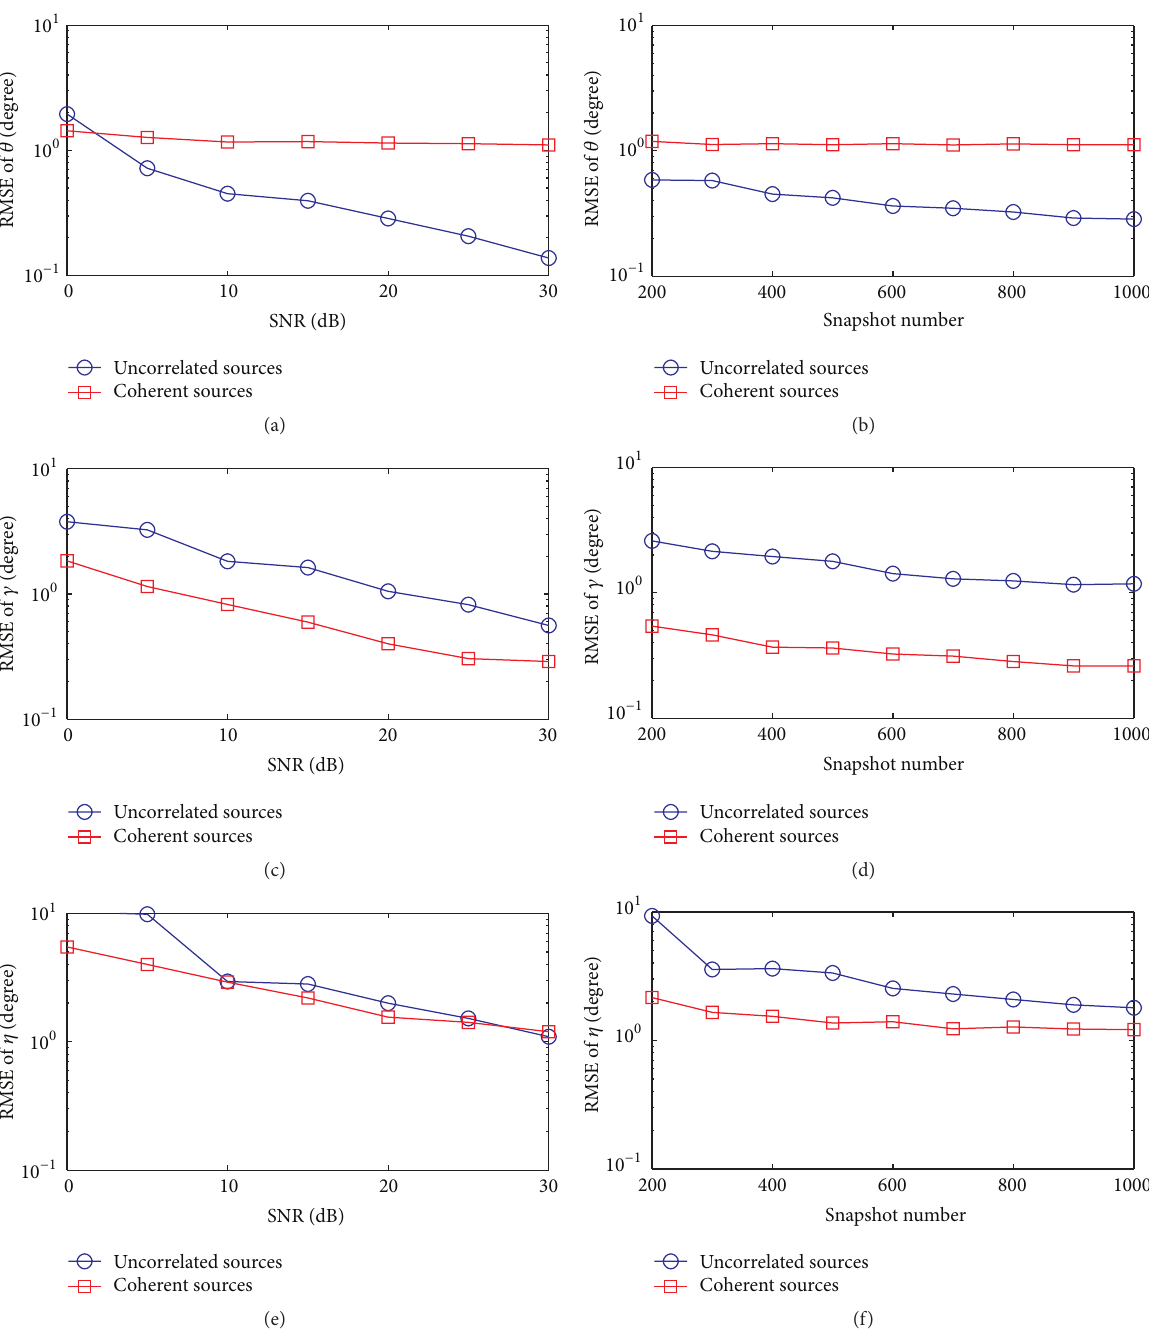
Figure 5: RMSE of angle and polarization parameter estimation versus SNR and snapshot number: (a) RMSE of 𝜃 versus SNR with the fixed snapshot number 500; (b) RMSE of 𝜃 versus snapshot number with the fixed SNR 20 dB; (c) RMSE of 𝛾 versus SNR with the fixed snapshot number 500; (d) RMSE of 𝛾 versus snapshot number with the fixed SNR 20 dB; (e) RMSE of 𝜂 versus SNR with the fixed snapshot number 500; (f) RMSE of 𝜂 versus snapshot number with the fixed SNR 20